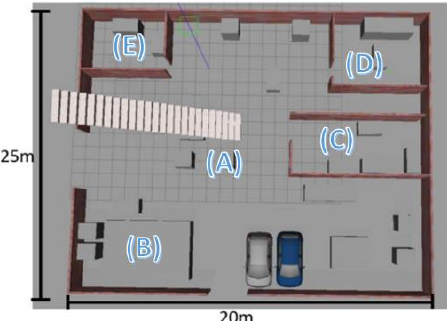
Figure 8. Map of the scenario #3—Industrial manufacturing area: machine zone 1 ( A ), machine zone 2 ( B ), machine zone 3 ( C ), machine zone 4 ( D ), and warehouse ( E ).